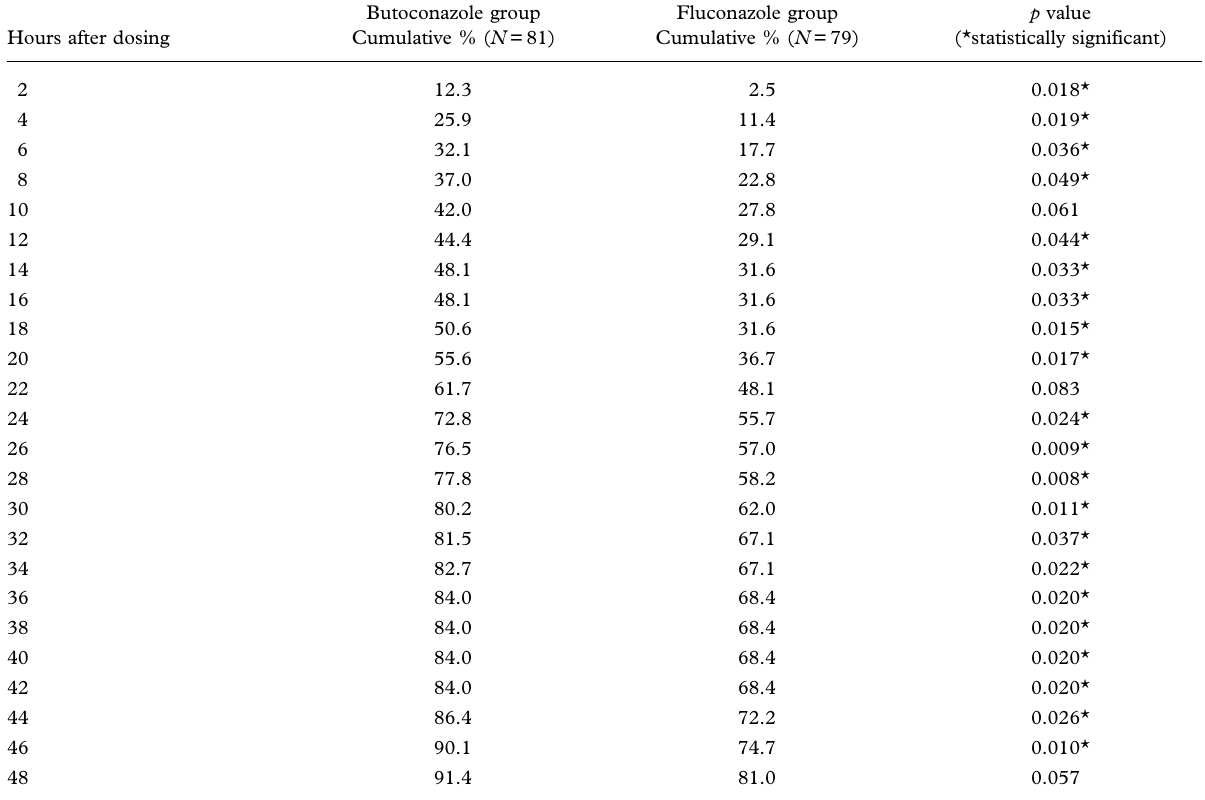
Table I. Cumulative percentage of patients with first relief of symptoms following dosing by treatment